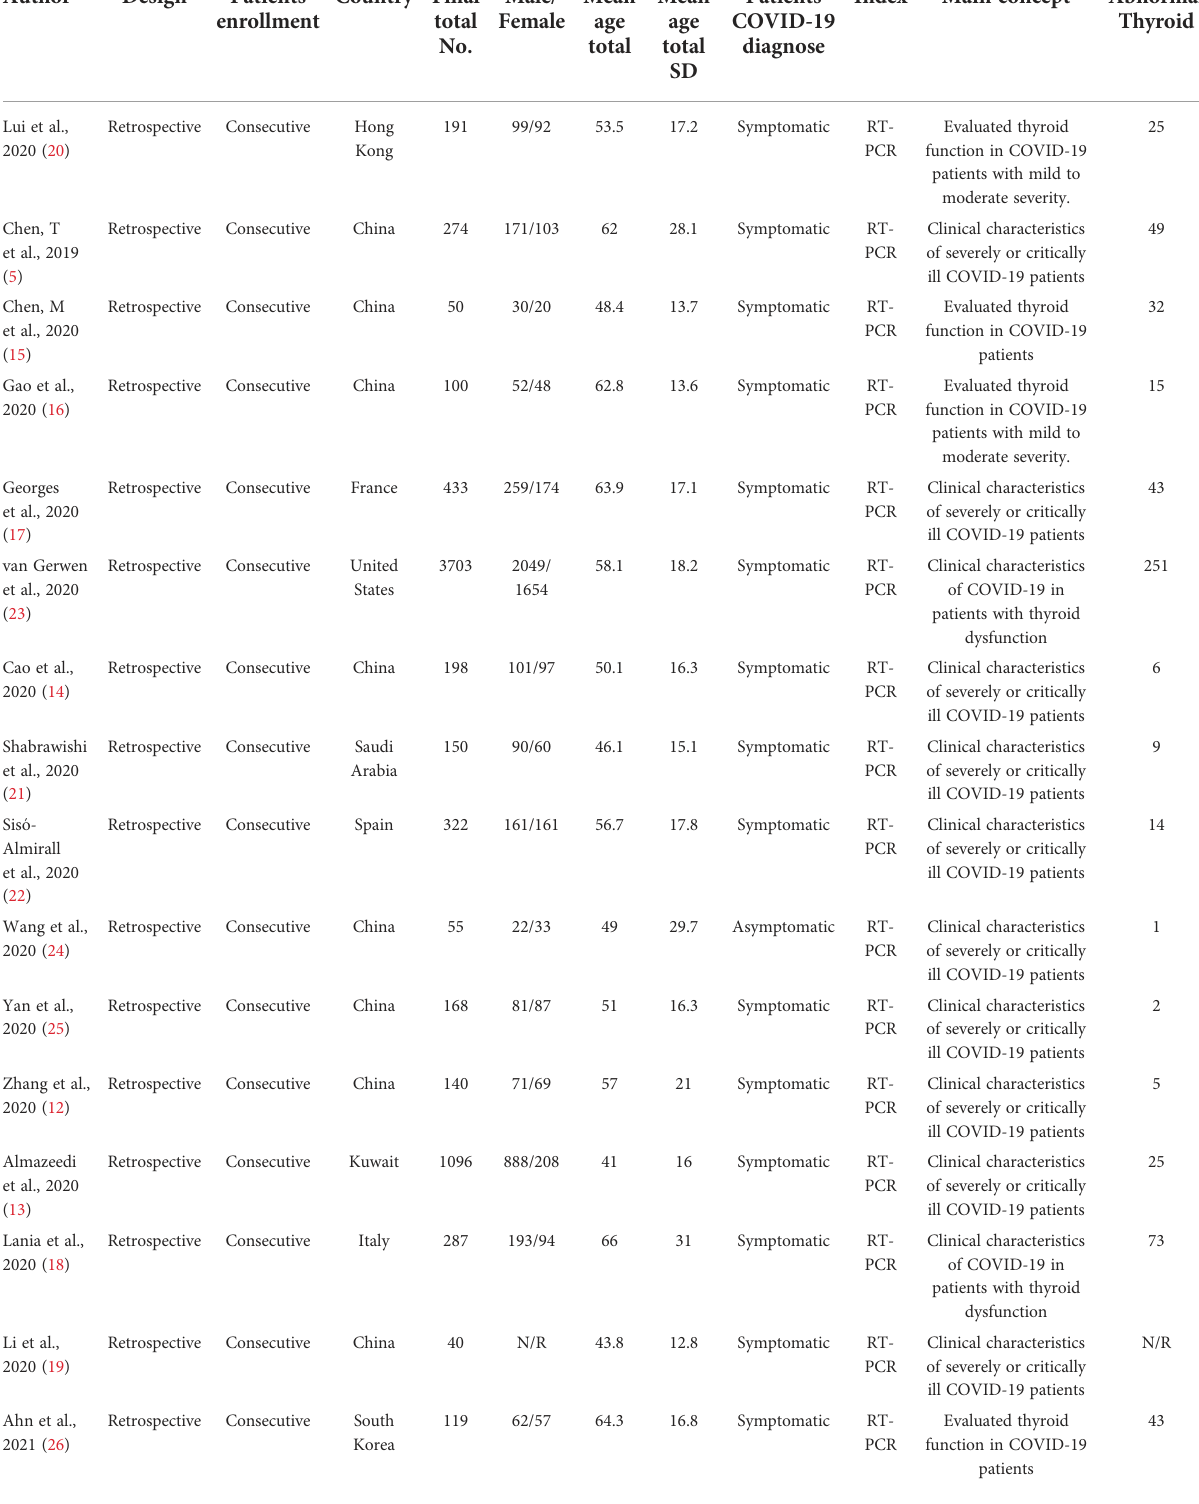
TABLE 1 The main characteristics of 30 studies from different countries with RT-PCR con fi rmed the diagnosis of